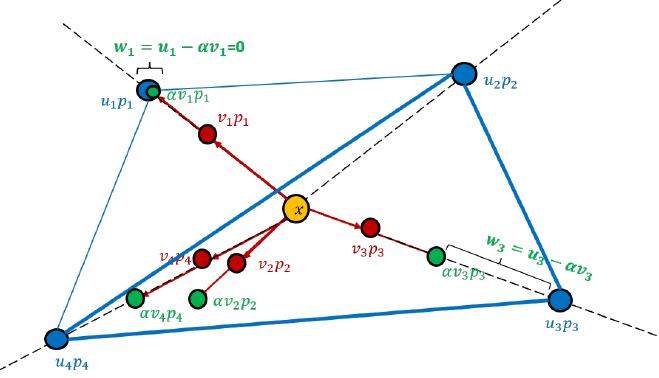
u i p i = 0 corresponds to four points (in Figure 2. A weighted set ( P , u ) whose weighted mean is ∑ 4 i = 1 blue) whose sum is the origin (in orange). Algorithm 1 first computes a weighted set ( P , v ) (red points) v i = 0. The weights are scaled by α > 0 whose weighted mean is the origin, and sum of weights is ∑ 4 i = 1 until α v i = u i for some i ( i = 1 in the figure). The resulting weighted set ( P , α v ) in green is subtracted from the input ( P , u ) to obtain ( P , u − α v ) = ( P , w ) , where w 1 = 0 so p 1 can be removed. Algorithm 1 then continues iteratively with the remaining points until ( P , w ) has | P | = d + 1 weighted